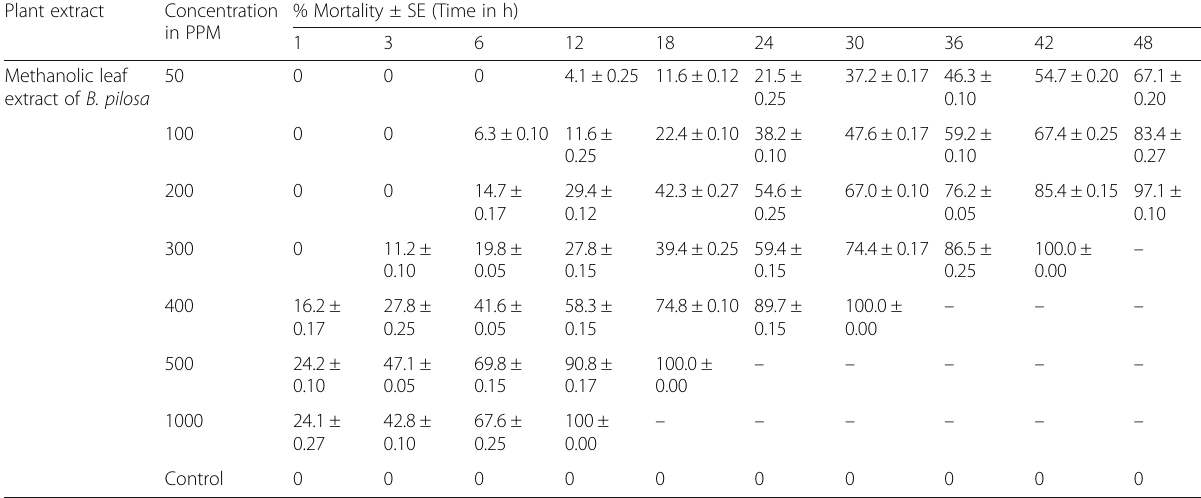
Table 7 Time dependent mortality check of larvicidal activity of crude methanolic extract of B. pilosa till 48 h at different concentrations Plant extract Methanolic leaf 50 extract of B. pilosa